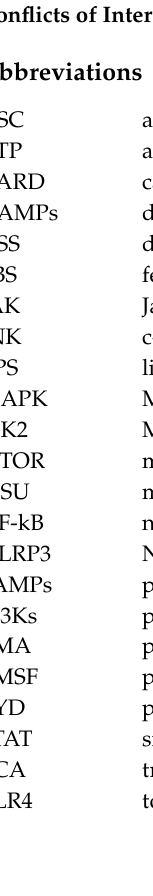
on IL-6 release reaction, Figure S4: E ff ect of 11Cha1 on LPS-induced MAPK phosphorylation, Figure S5: E ff ect of 11Cha1 and NAC on inhibition of ROS production, Figure S6: E ff ect of 11Cha1 on poly (dA:dT)-induced IL-1b